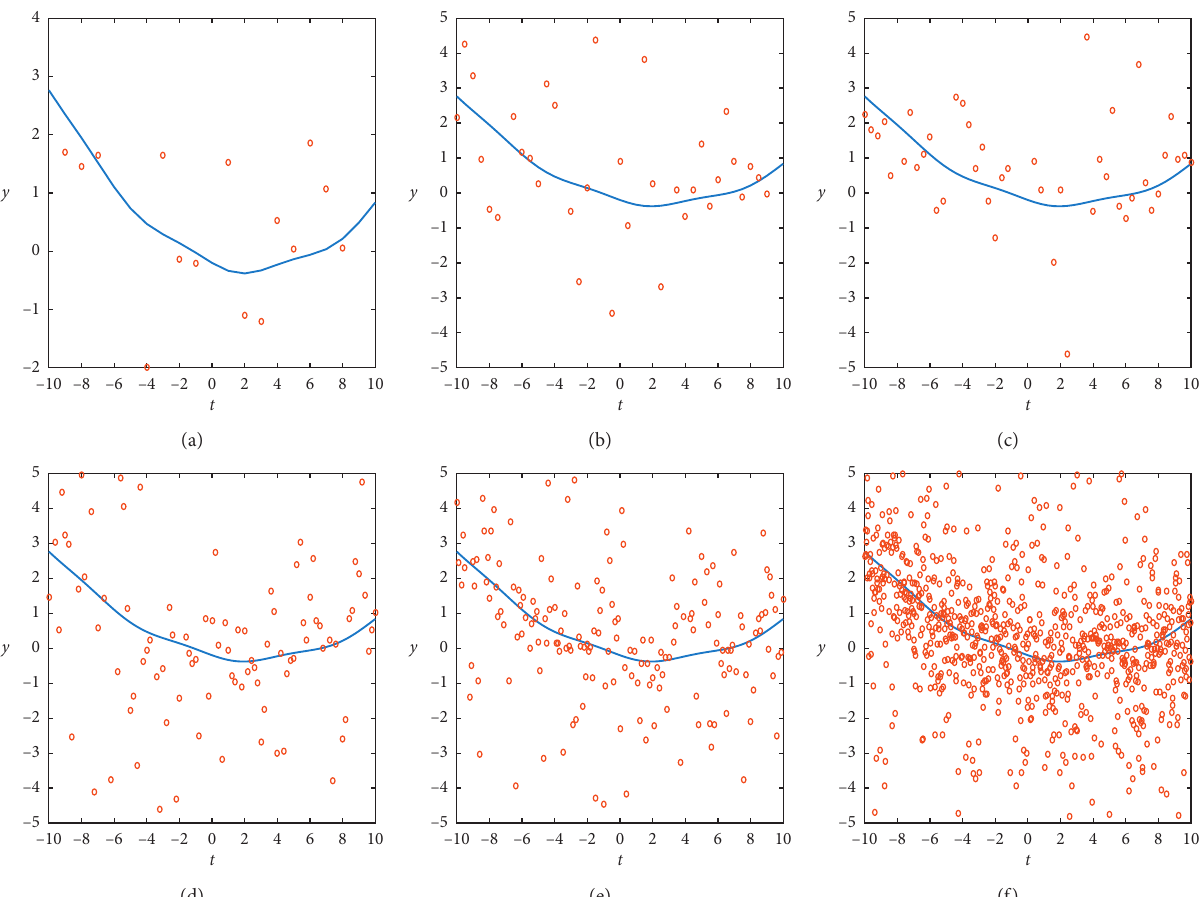
Figure 7: Generated signals with different sample sizes. The curves denote f ( t ; θ ) . The circles denote y ( t ) . (a) n � 20. (b) n � 40. (c) n � 50. (d) n � 100. (e) n � 200. (f) n �